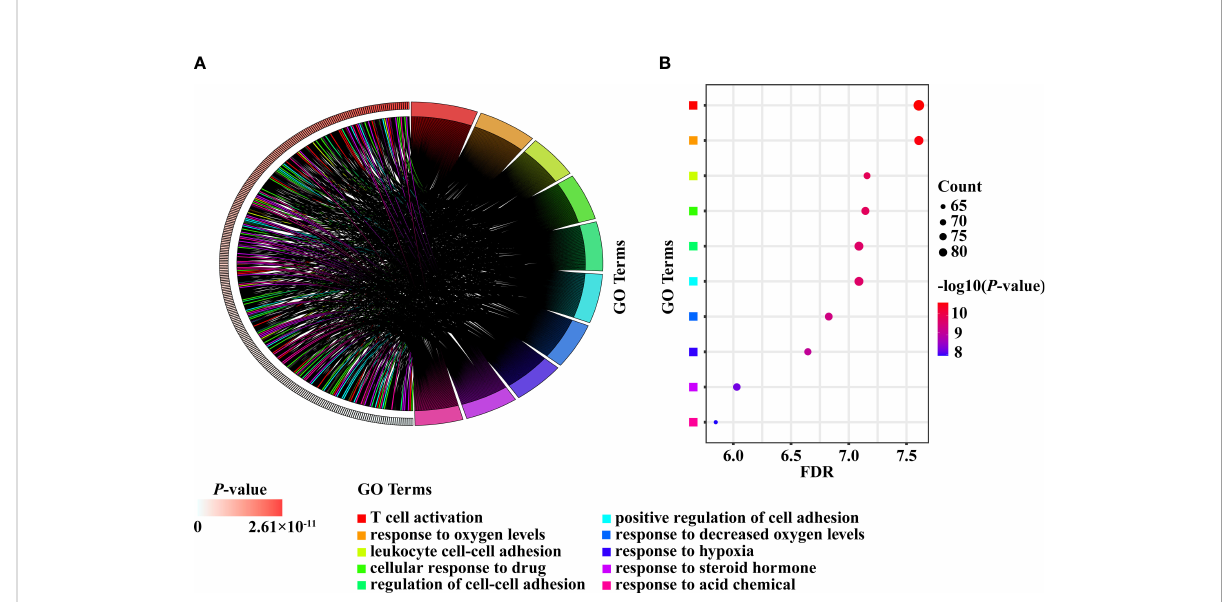
FIGURE 7 The top ten enriched pathways shared between PCOS patients and PNA mice. (A) Chord diagram. (B) Bubble